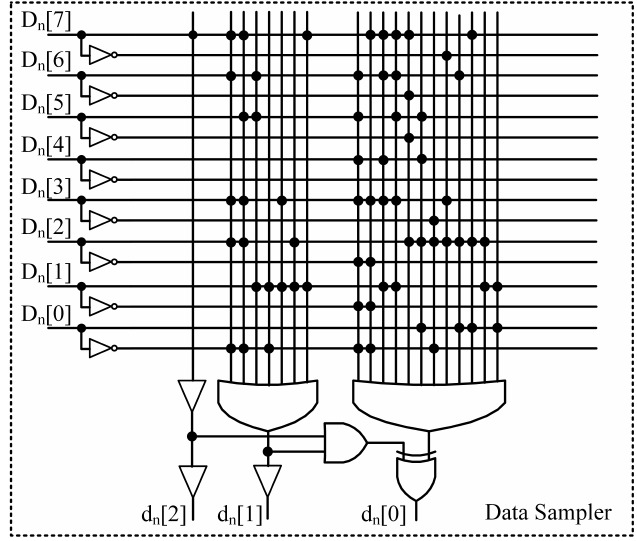
Figure 6. Logic gate circuit of Data